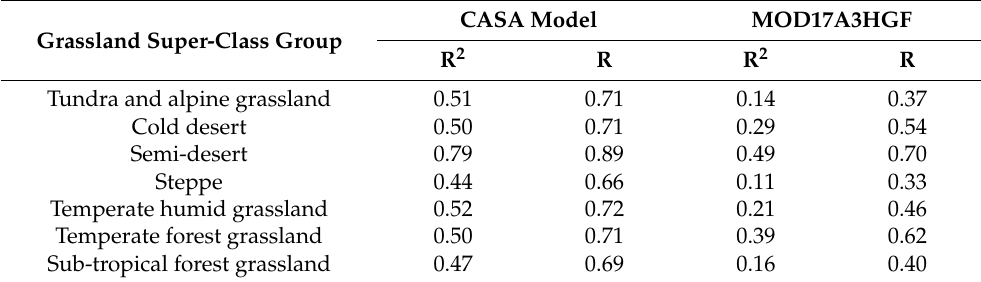
Table A5. The comparison between the observed and estimated NPP values by the CASA model and the MOD17A3HGF product.